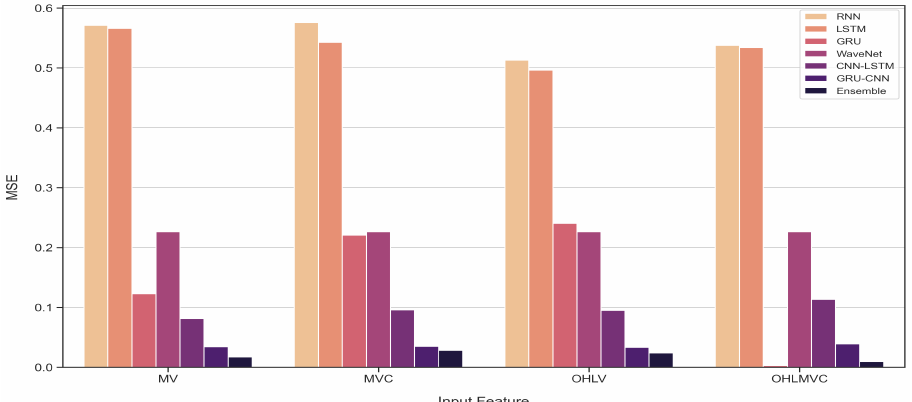
Figure 17. Comparison of the average MSE of all models using MV, MVC, OHLV, and OHLMVC.